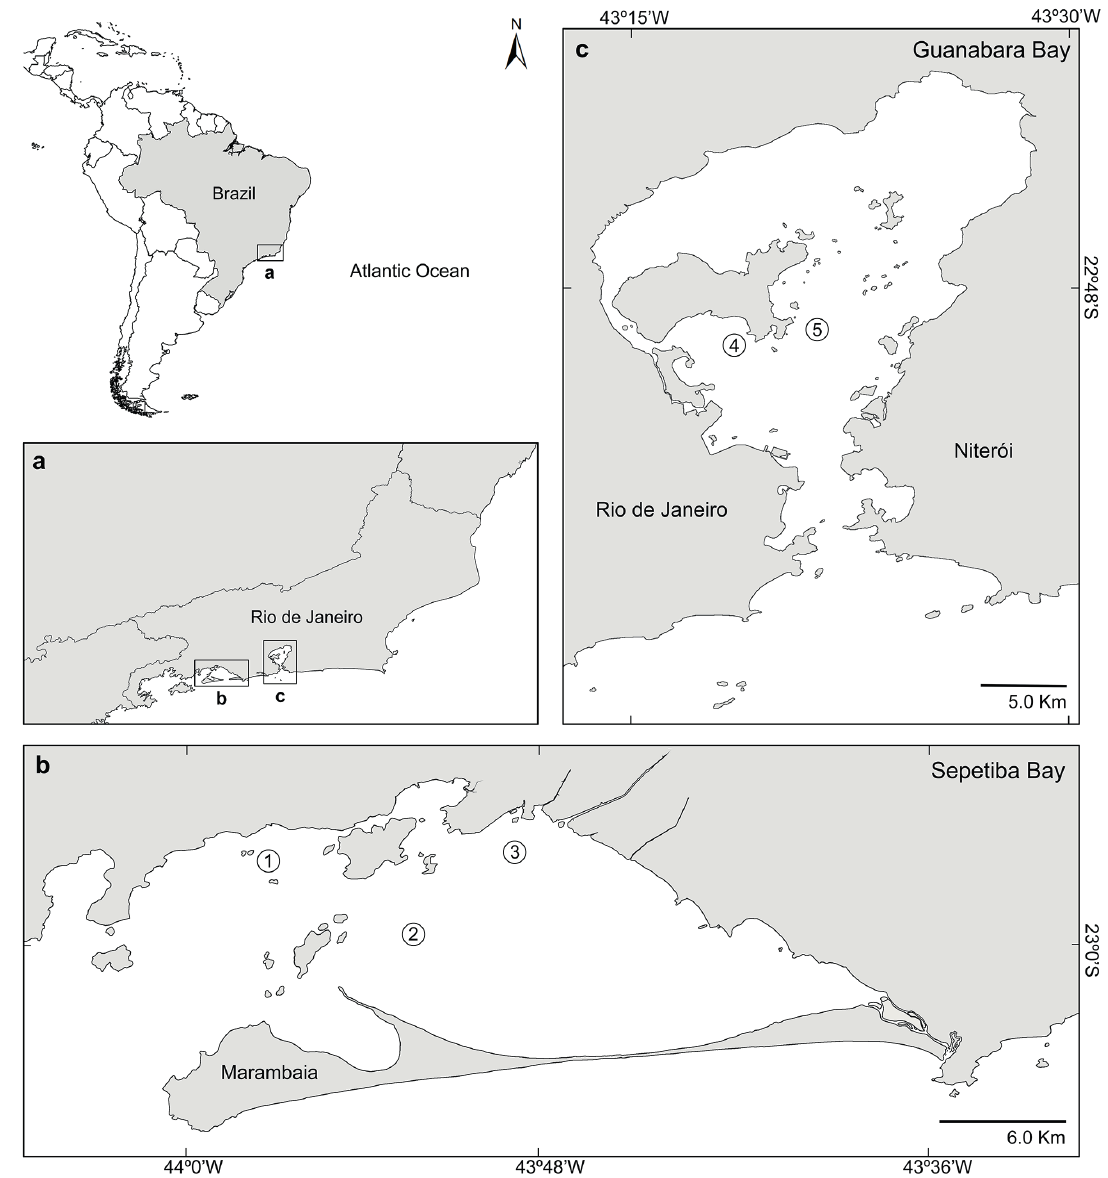
Figure 1 - ( a ) Rio de Janeiro State, Brazil. Sampling areas in ( b ) Sepetiba Bay: 1: outer; 2: central; 3: inner areas, and ( c ) guanabara Bay: 4: Fundão; 5: central channel. SHRIMP SAMPlINgS AND lAB